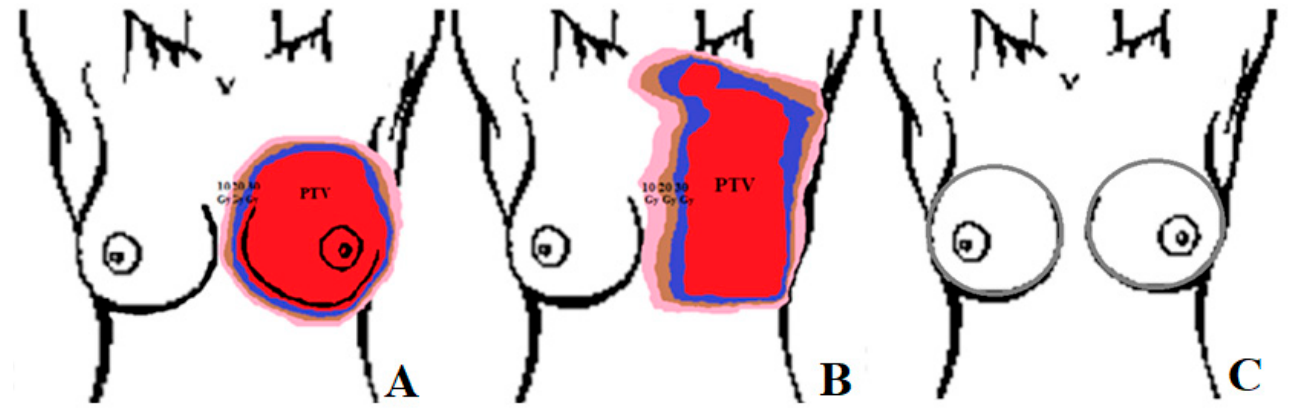
Figure 1. Diagram of the method of drawing isodoses in patients after conserving surgery ( A ) and mastectomy ( B ) qualified for radiotherapy. The PTV area is marked in red, the dose area of 30 Gy in dark blue, the dose of 20 Gy in brown, and 10 Gy is pink. Scheme of drawing the breast area on thermograms in a group of healthy patients ( C ).